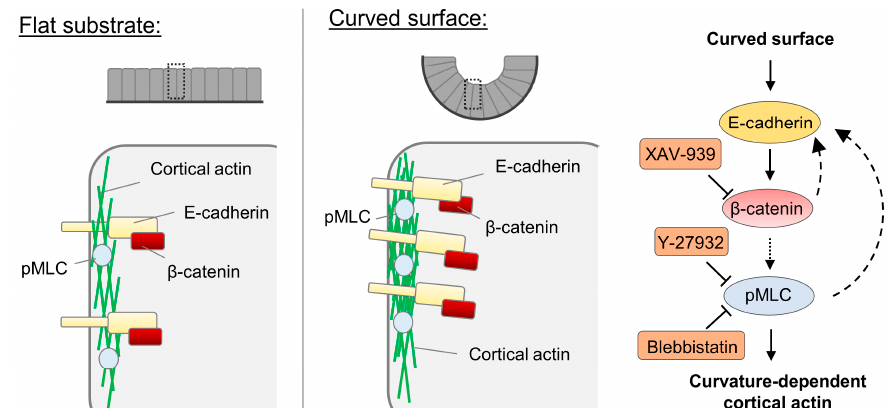
Figure 3. Proposed model for the increased cortical actin assembly in epithelium on the curved surface. The capacity of epithelial cells collectively sensing the curvature at the length scale of tens of micros is manifested by elevated E-cadherin and myosin phosphorylation along the cell edge. Our results indicate that through β -catenin-dependent signaling, cortical actin assembly is increased. Feedback regulation of E-cadherin by the myosin activity and β -catenin is also proposed here based on the results.